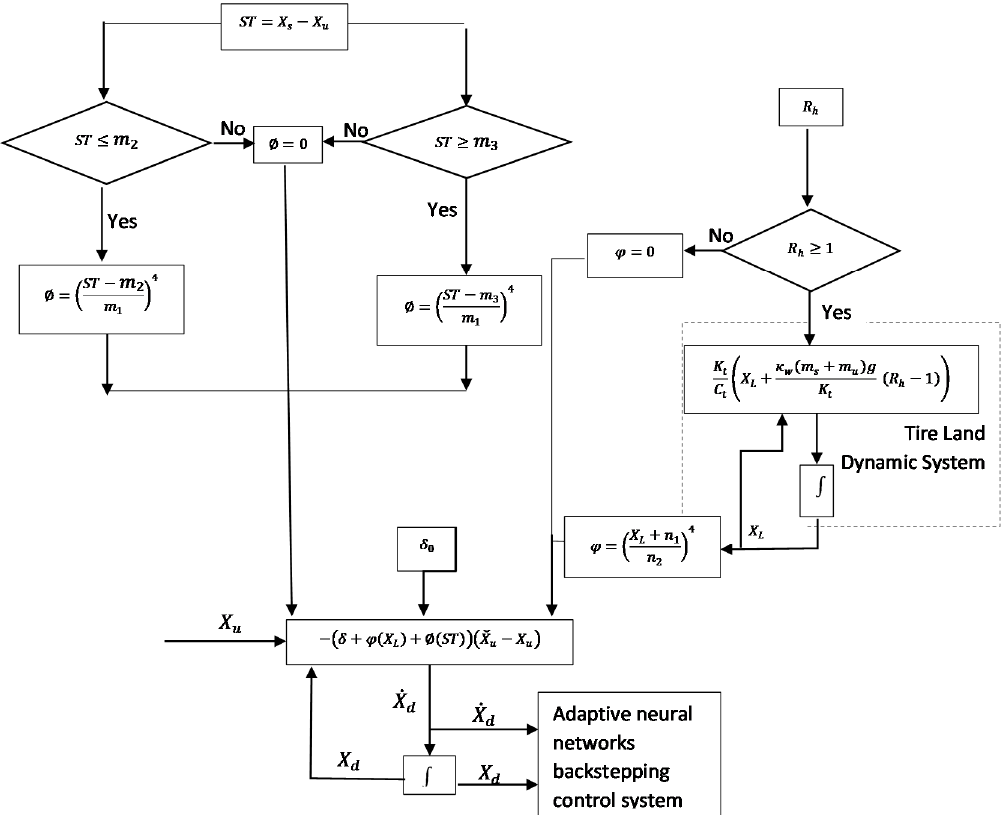
Figure 3. Filtered active suspension flow chart.